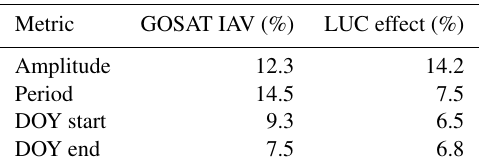
Table 3. The interannual variation (IAV) in XCO 2 seasonal cycle metrics, presented as the relative standard deviation (i.e., RSD or coefficient of variation) and the LUC effect, defined as the change in the XCO 2 seasonal cycle metrics when land use change is included in simulations, relative to simulations with only natural vegetation. The values for IAV and the LUC effect presented below are first calculated for each region and segment type (rise, fall) and then av- eraged over all regions and models (for the LUC effect). The values for the phasing metrics (day of year, DOY) are calculated using the period as the